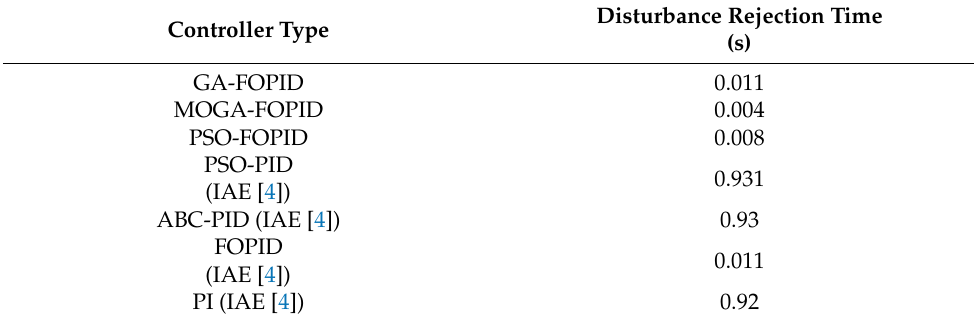
Table 7. Step disturbance